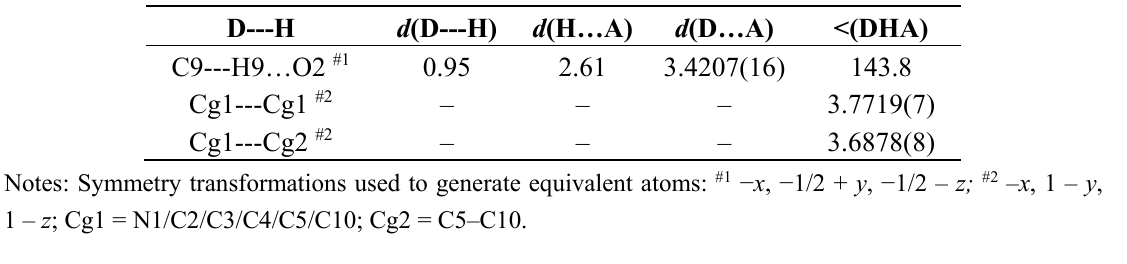
Table 4. Weak Intermolecular Interactions for (II) C 17 H 13 NO 3 , (Å and